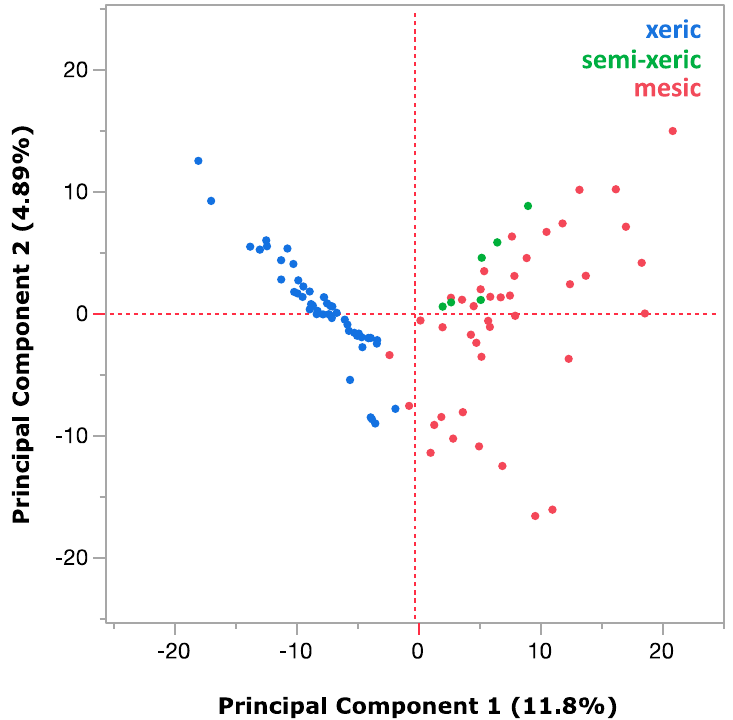
Figure 4. Principal component analysis of all of the moss samples analyzed in this work (blue: xeric mosses; green: semi-xeric mosses; red: mesic moss and lichens). Xeric and mesic mosses show distinct clusters, and semi-xeric mosses tend to shift from the mesic mosses and lichens towards the xeric mosses.